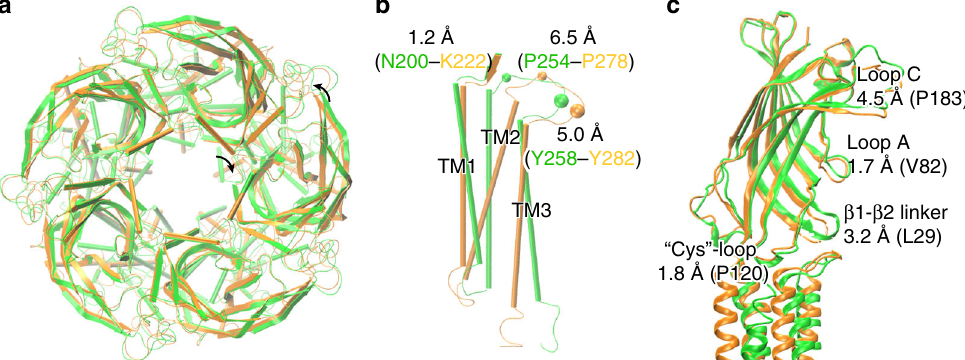
Fig. 7 Structural changes in the ECD due to different TMDs. a Top view of crystal structures of apo ELIC- α 1GABA A R (orange) and apo ELIC (green), aligned along all ECD residues. b Displacements of C α atoms of equivalent residues in apo ELIC- α 1GABA A R and apo ELIC in the pre-TM1 and the TM2 – TM3 loop are labeled. Both the pre-TM1 and TM2 – TM3 loop regions may affect the ECD. c Structural changes in the ECD are measured by displacements of the highlighted residues in several key regions